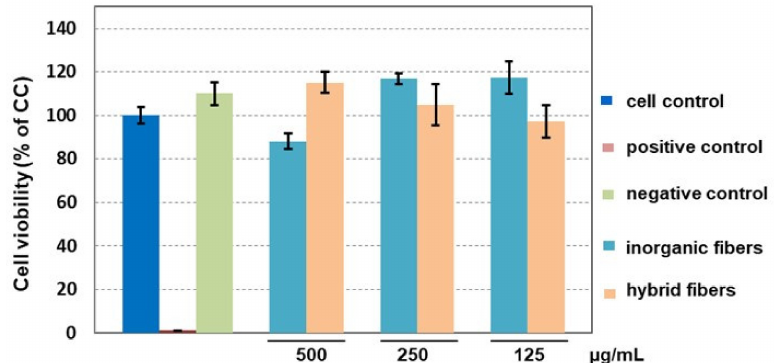
Figure 7. Comparison of the impact of hybrid DACHsilane nanofibres on the viability of 3T3-A31 cells compared to inorganic silica dioxide nanofibres as a